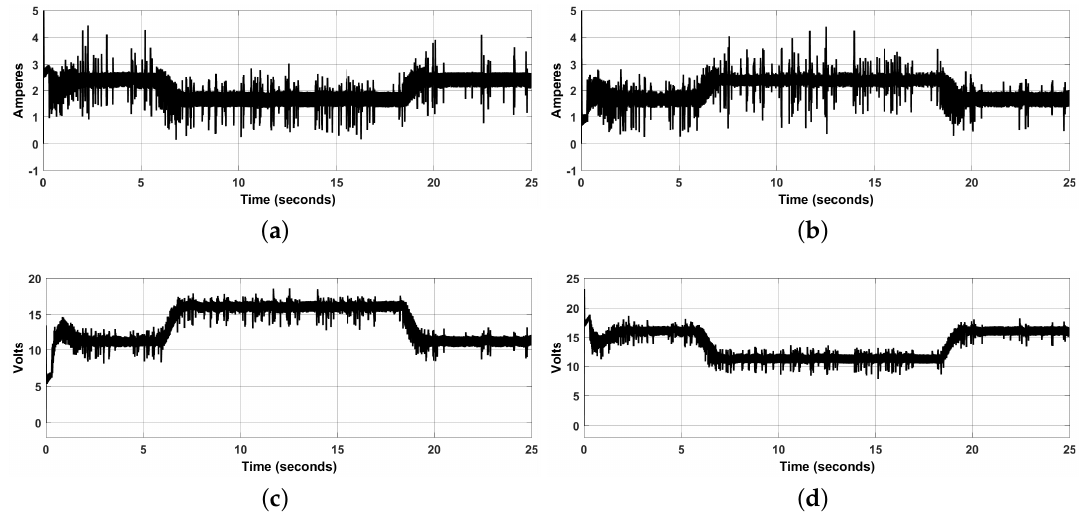
Figure 6. Power electronic converter variables. ( a ) Electric current in the Buck converter inductor no. 1 (right), i c 1 . ( b ) Electric current in the Buck converter inductor no. 2 (left), i c 2 . ( c ) Voltage at the Buck converter capacitor no. 1 (right), V 1 . ( d ) Voltage at the Buck converter capacitor no. 2 (left), V 2 .